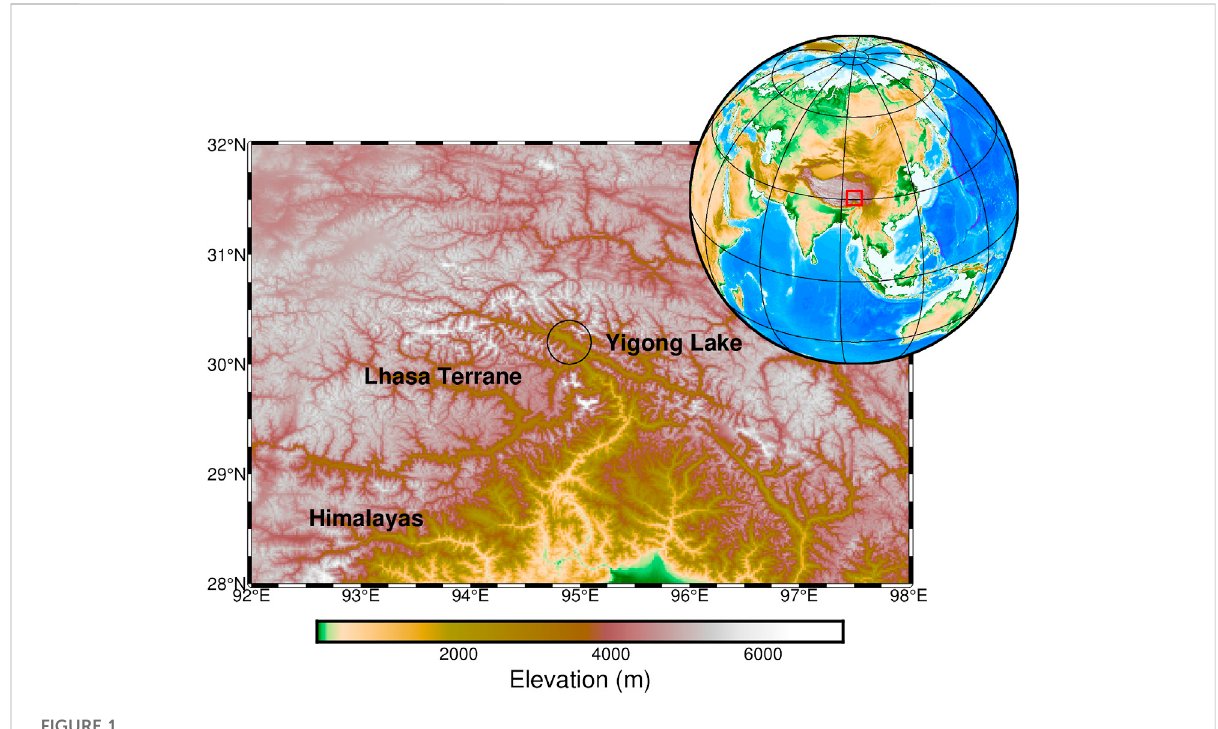
FIGURE 1 Geographic location and map